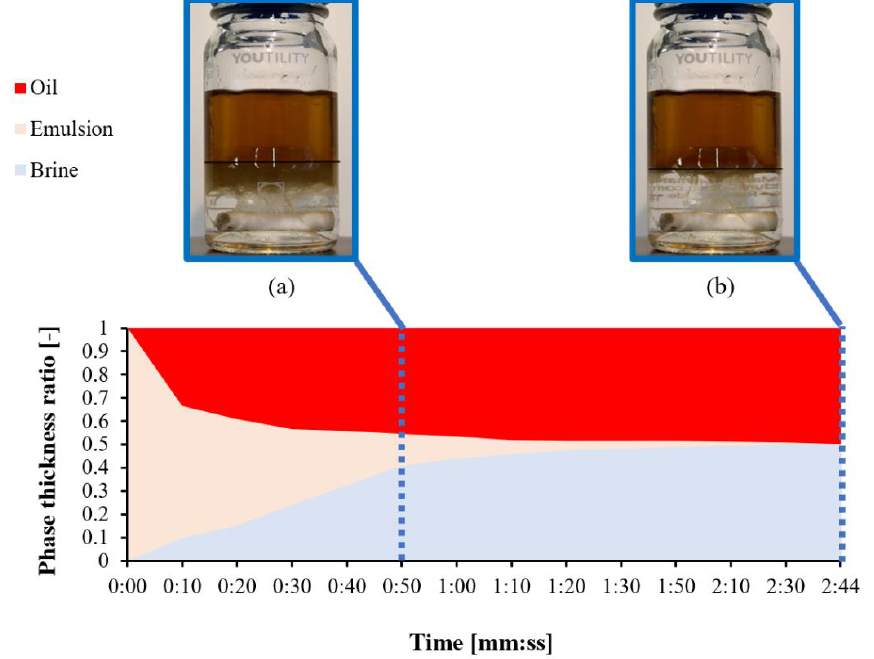
Figure 3. Separation bottle depicting Exxsol D60 with crude oil, WC 50% — conditions of test bottle at ( a ) t in and ( b ) t sep .